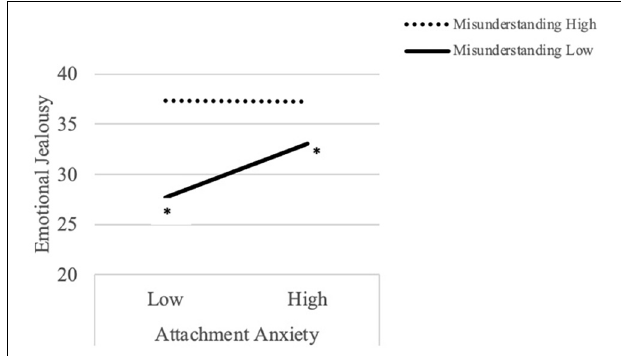
FIGURE 3 | Attachment style and concern about misunderstandings interact to predict emotional